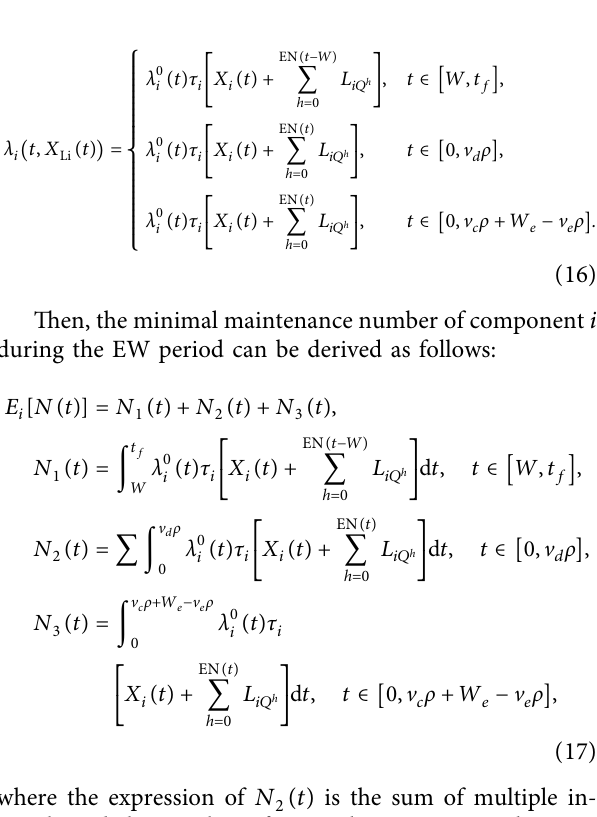
Figure 5: CBM strategy diagram. PR represents preventive re- placement, while OR denotes opportunistic preventive